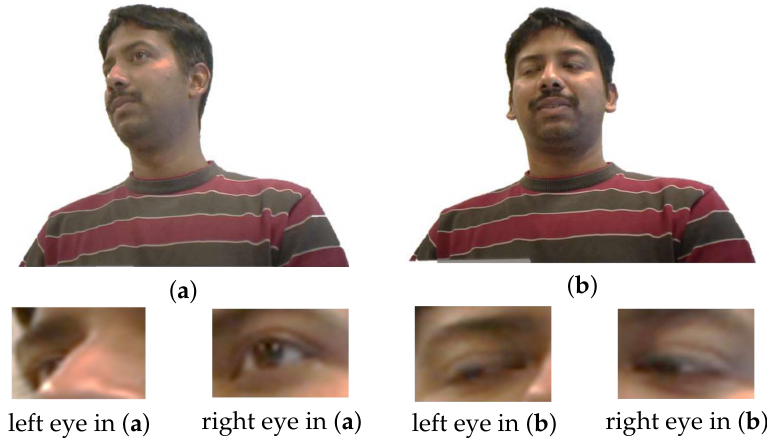
Figure 3. Example of noise images in Eyediap [20]. ( a , b ) are two example frames of the dataset. ( Top ) Original RGB frames. ( Bottom ) Left- and right-eye images are captured from the original RGB